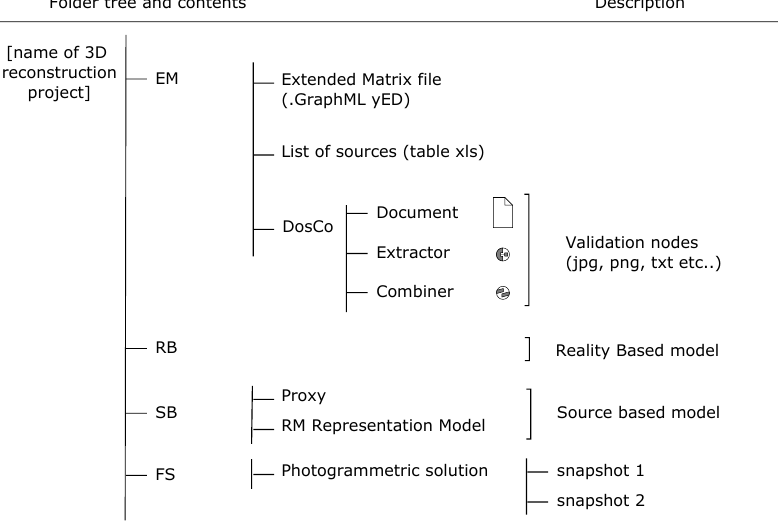
Figure 16. Outline of the suggested folder structure for a reconstruction